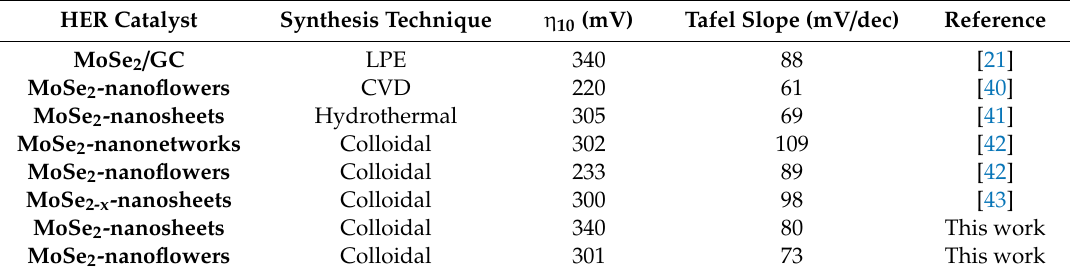
Table 1. Comparison of η 10 and Tafel slopes values of MoSe 2 synthesized using di ff erent techniques. HER Catalyst